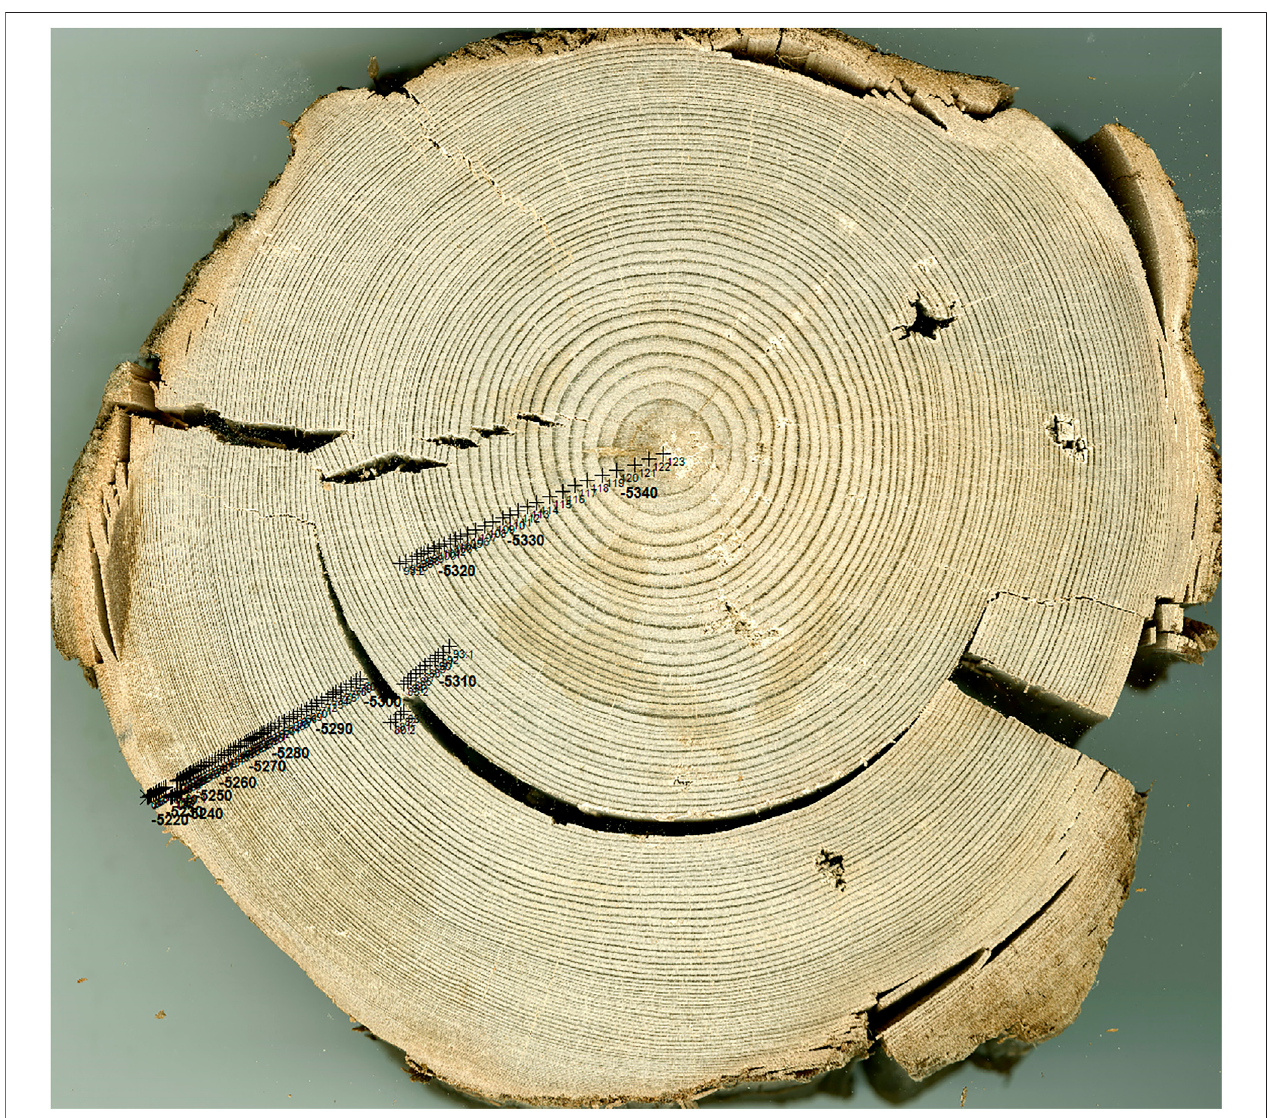
FIGURE 2 | Scanned cross-section of a typical subfossil pinewood sample with tree rings measured in CooRecorder software (Rydval et al., 2014; Maxwell and Larsson, 2021). Measurements of this sample were carried out in three longer and one short separate segment, minding the gap formed during the shrinkage, perpendicularly to ring boundaries. Image by Hannu Herva (22 April